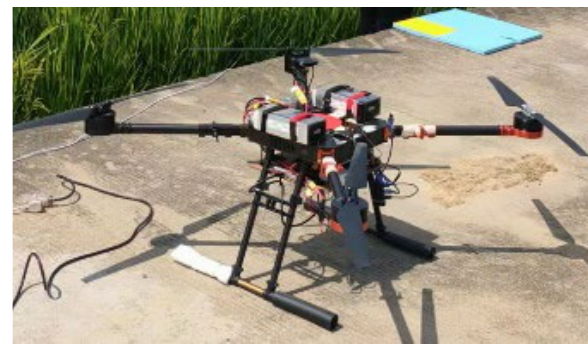
Figure 1. UAV used in this study for plant protection. Table 1. Specifications of th e UAV. Table 1. Specifications of the